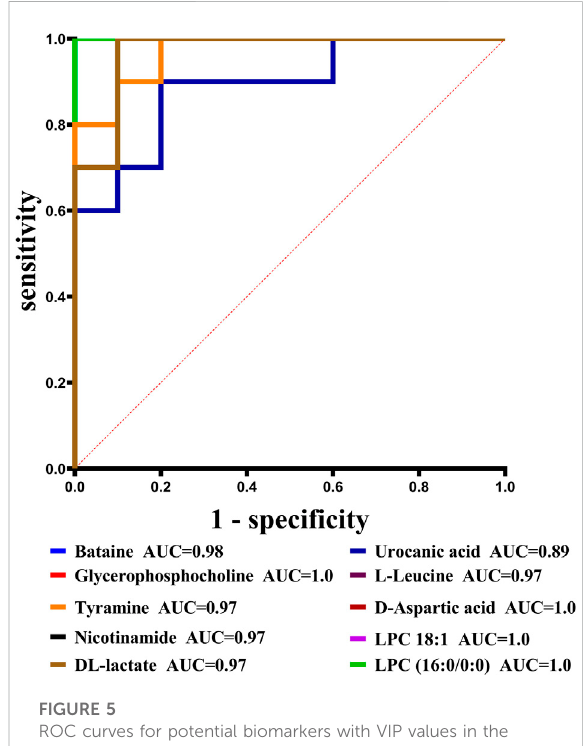
FIGURE 5 ROC curves for potential biomarkers with VIP values in the top